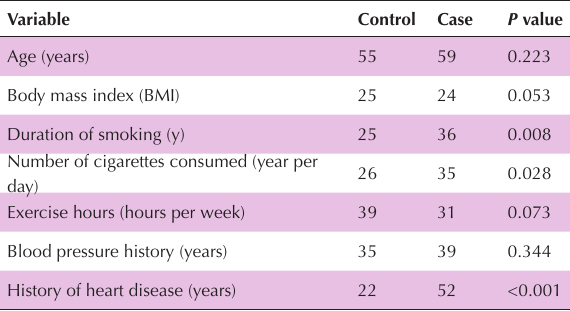
Table 1. Results for variables such as age, BMI, duration of smoking, number of cigarettes, number of exercise hours per week, history of hypertension and history of heart